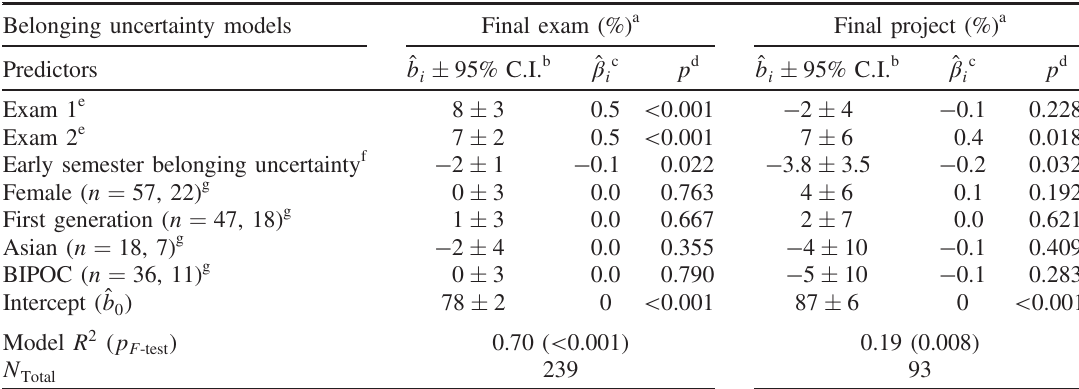
TABLE IV. Final assessment multiple regression (belonging uncertainty)